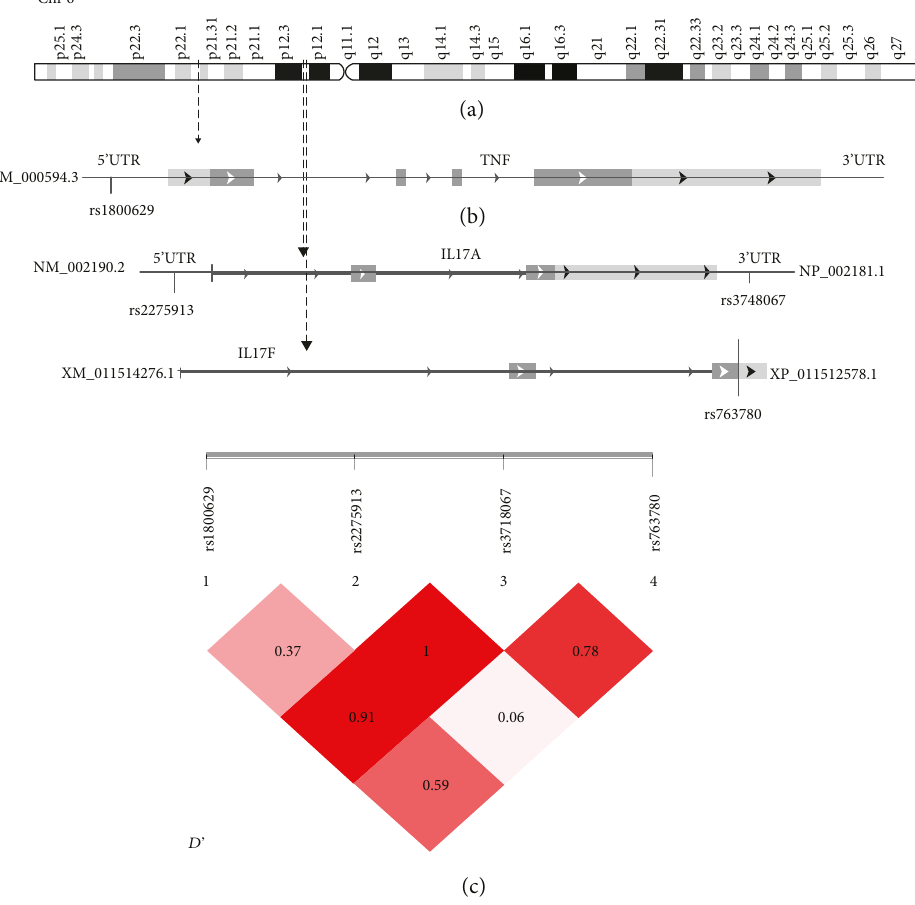
Figure 2: Overview and linkage disequilibrium (LD) on chromosome 6. (a) Overview of chromosome 6. (b) Schematic structure of the IL17A , IL17F , and TNFa genes. The positions of the four SNPs are shown by the arrows (c). LD prime charts generated using SHEsis software summarize LD ( D ’ ) patterns between the 4 SNPs. D ’ > 0.7 is considered as a high value of